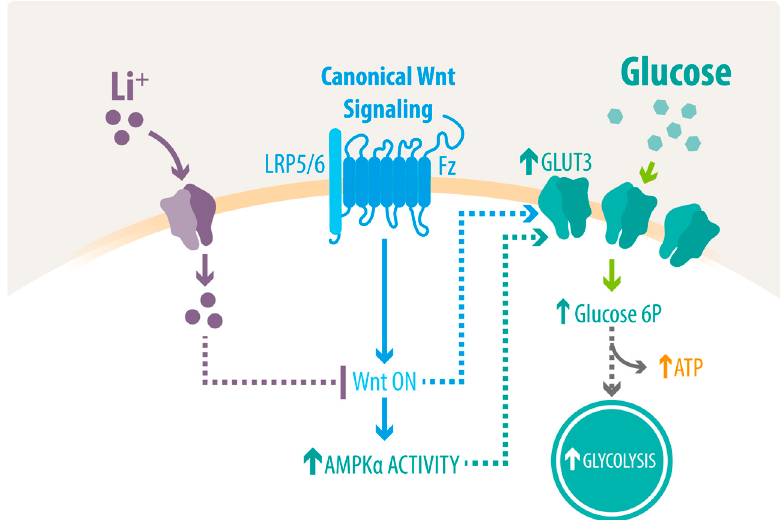
Figure 6. Schematic model for the action mechanism of lithium. Once internalized, lithium results in the activation of the canonical Wnt signaling pathway, promoting AMPK activation. Both AMPK and the Wnt pathway activation can trigger the upregulation of neuronal Glut3, resulting in glucose metabolism restoration by the stimulation of glucose uptake, increased glycolysis, and elevated ATP levels. Dashed lines indicate the participation of several proteins.